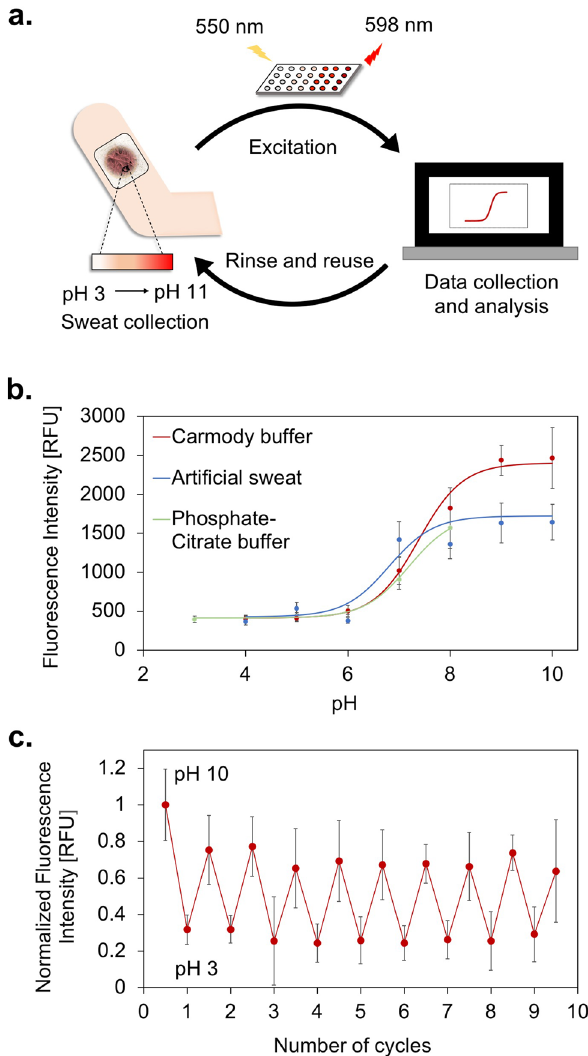
Figure 4. Wearable protein–textile composites for fluorescent pH sensing. ( a ) A scheme representing the steps involved in the working of our textile–protein sensor. ( b ) Fluorescence intensities of the textile at pH conditions ranging from 3–11 in three types of solutions—artificial sweat, Carmody buffers and phosphate-citrate buffers. The non-linear fit for all three curves was performed using the Henderson–Hasselbalch equation (Eq. 4). ( c ) The reversible fluorescence behavior of the acrylic–CsgA–pHuji composite observed at two distinct pHs (pH 3 and pH 10) over 10